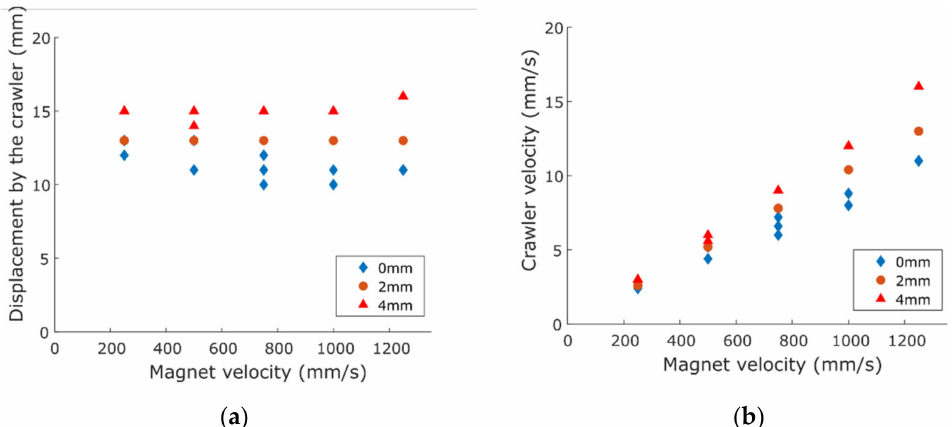
Figure 12. Scatter plot of ( a ) the displacement by the MAE crawler in 5 cycles against the average velocity of the magnet, and ( b ) average crawler velocity against the average velocity of the magnet in horizontal pipe with 0 mm, 2 mm and 4 mm magnet distance from the pipe in the case of caterpillar locomotion. Due to repeated data points, there are less than 3 observable data points for certain